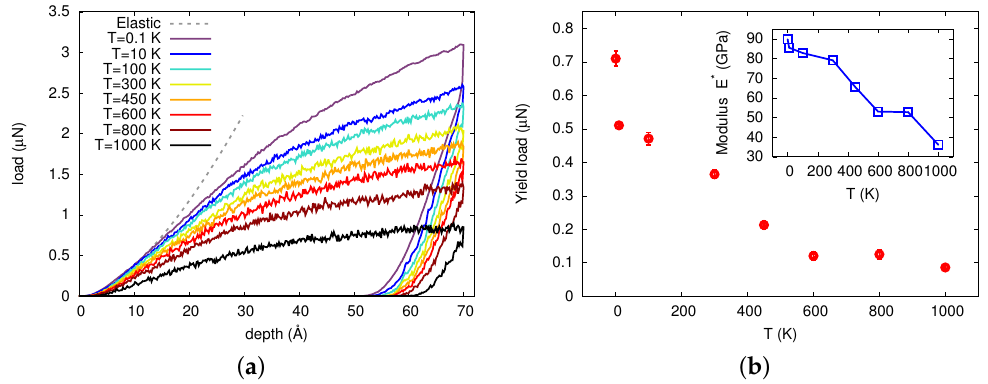
Figure 1. ( a ) Indentation load vs. indentation depth for different temperatures T . The dashed gray curve corresponds to the fitted elastic response, Equation (2). ( b ) Value of the load at the yielding point as a function of temperature. Inset: reduced elastic modulus E ∗ as a function of